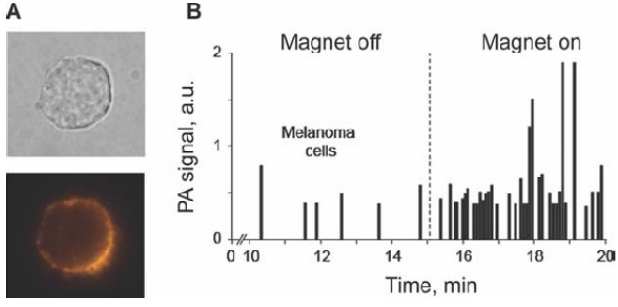
Figure 16. In vivo targeting of circulating SK-MEL-1 human melanoma cells in mouse blood. ( A ) MSCP expression by SK-MEL-1 cells, transmission (top) and fluorescence (bottom) images of a cell labeled with anti–human MSCP-Abs conjugated with PE fluorescent dye; ( B ) PAFC trace in tumor-bearing mouse model 10 min after CTC targeting by 50 nm MNPs conjugated with anti-human MSCP-Abs before and during magnet